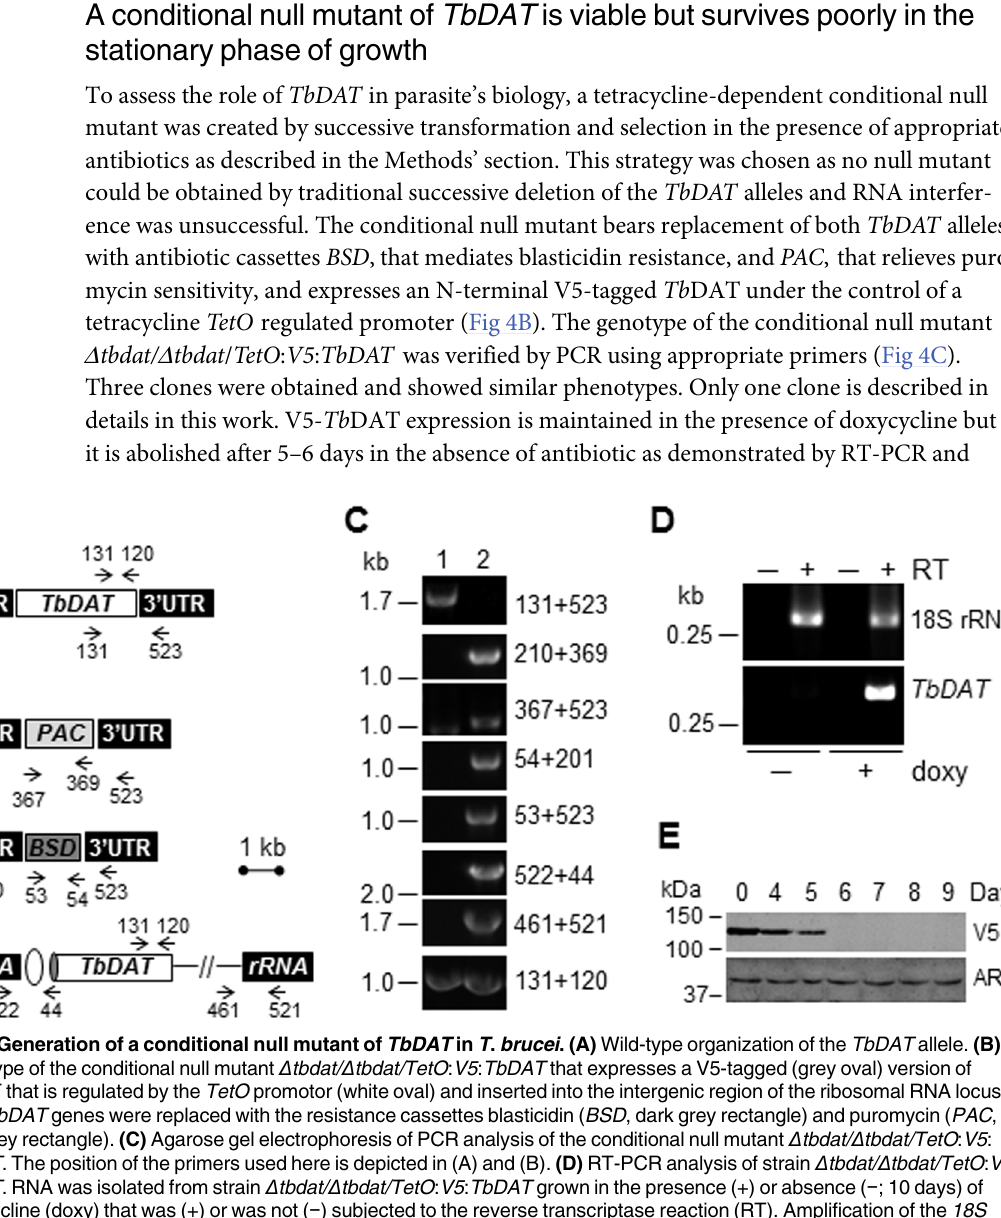
PLOS ONE | https://doi.org/10.1371/journal.pone.0181432 July 17,